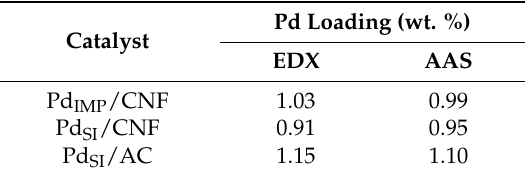
Table 3. Palladium loading from energy dispersive X-ray (EDX) and atomic absorption spectroscopy (AAS) data for the catalysts studied.